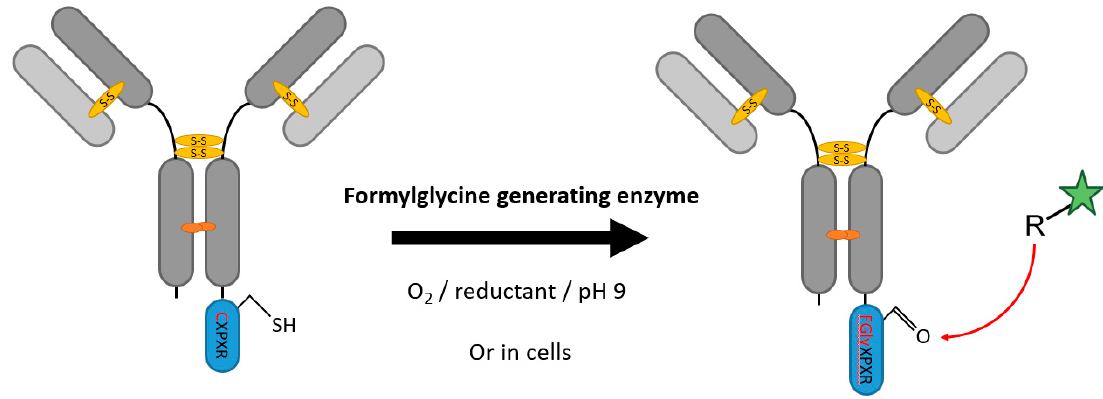
Figure 2. Scheme of an antibody modification with the fromylglycine-generating enzyme. For clarity, the reaction is only depicted in one heavy chain. R represents a moiety with an aldehyde reactive function capable of coupling via, e.g., hydrazino-iso-Pictet-Spengler Ligation, trapped Knoevenagel Ligation, or Wittig reaction.